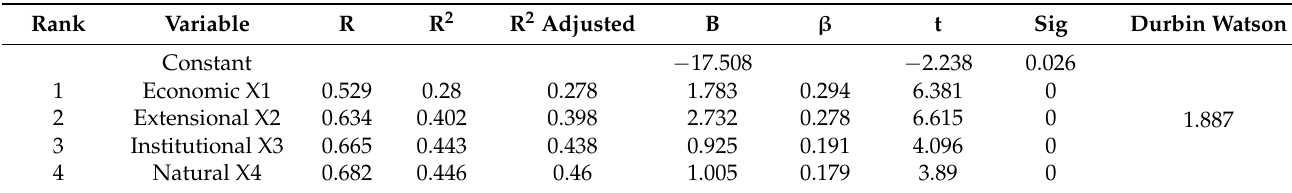
Figure 3. The explored model of the WCBs of wheat farmers. Table 8. Multivariate